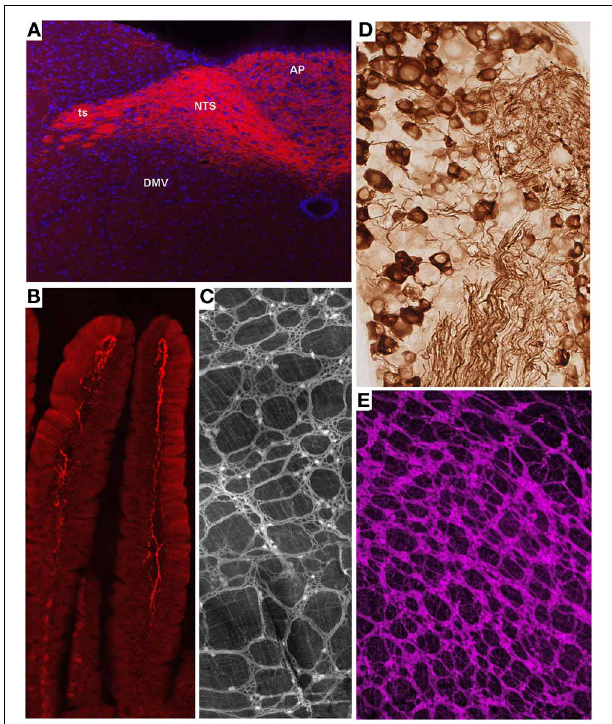
FIGURE 2 | Representative examples of transgenic approaches that enable the marking of restricted gut-brain axis neurons in the mouse. (A) Vagal sensory neurons in the NG of MC4R-GFP mouse stained with an anti-GFP antibody and diaminobenzidine. Notably, both the cell bodies and axons of vagal sensory neurons are clearly labeled. (B,D) Fluorescently labeled terminal fibers in the dorsovagal-complexand duodenummucosa of a Na v 1.8-Cre-tdTomato mouse. (C) Whole-mount of the ileal myenteric plexus of a Phox2b-Cre-tdTomatomouse revealing vagal extrinsic innervation and isolated innervation of enteric neurons. (E) Whole-mount of the gastric myenteric plexus of a ChAT-Cre-tdTomato mouse containing fluorescent preganglionic fibers intermingled with cholinergic enteric neurons that reveals the myenteric plexus. The above images are all unpublished and were generated in our laboratory using mouse lines described in the